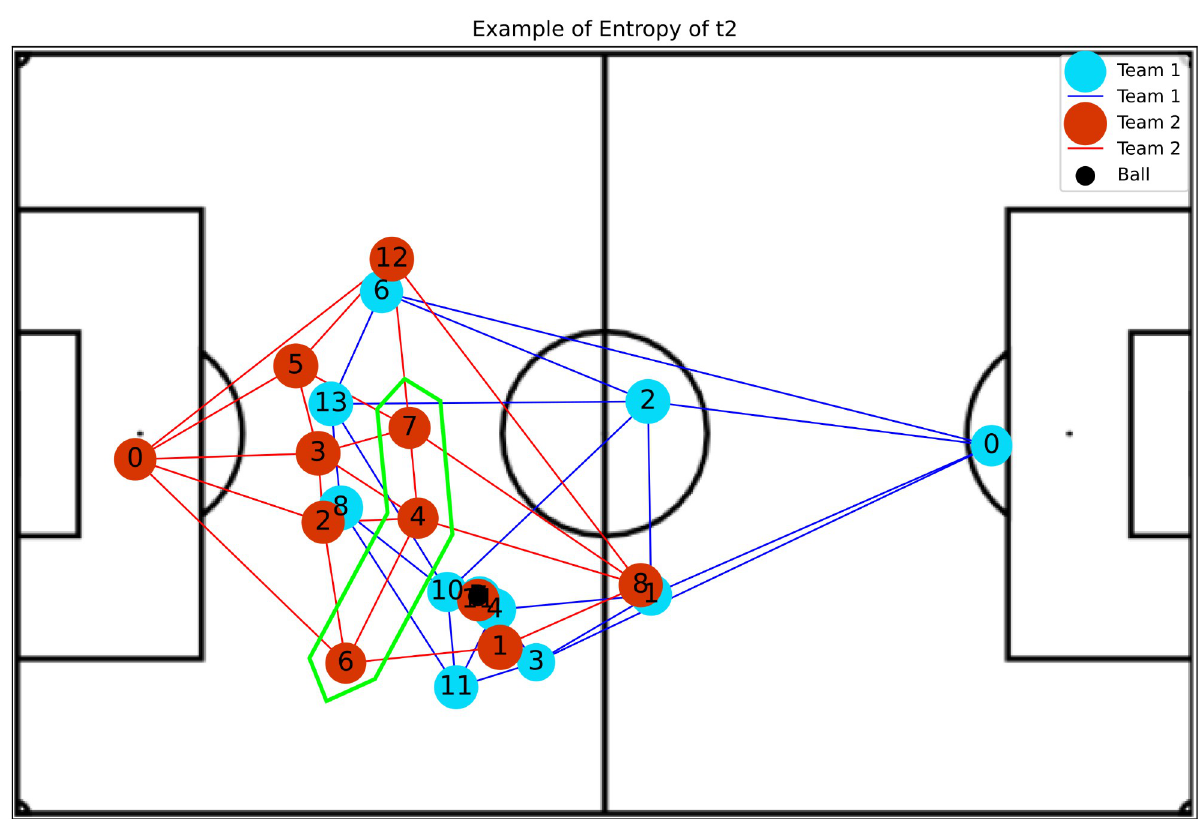
Fig 7. The image illustrates a high entropy situation for team t2 (without ball possession), where it is possible to observe that players 7, 4, and 5 (the region highlighted in green in the figure) are far from players of the team with possession, thus not marking any opponent, thus facilitating the performance of passes between opposing